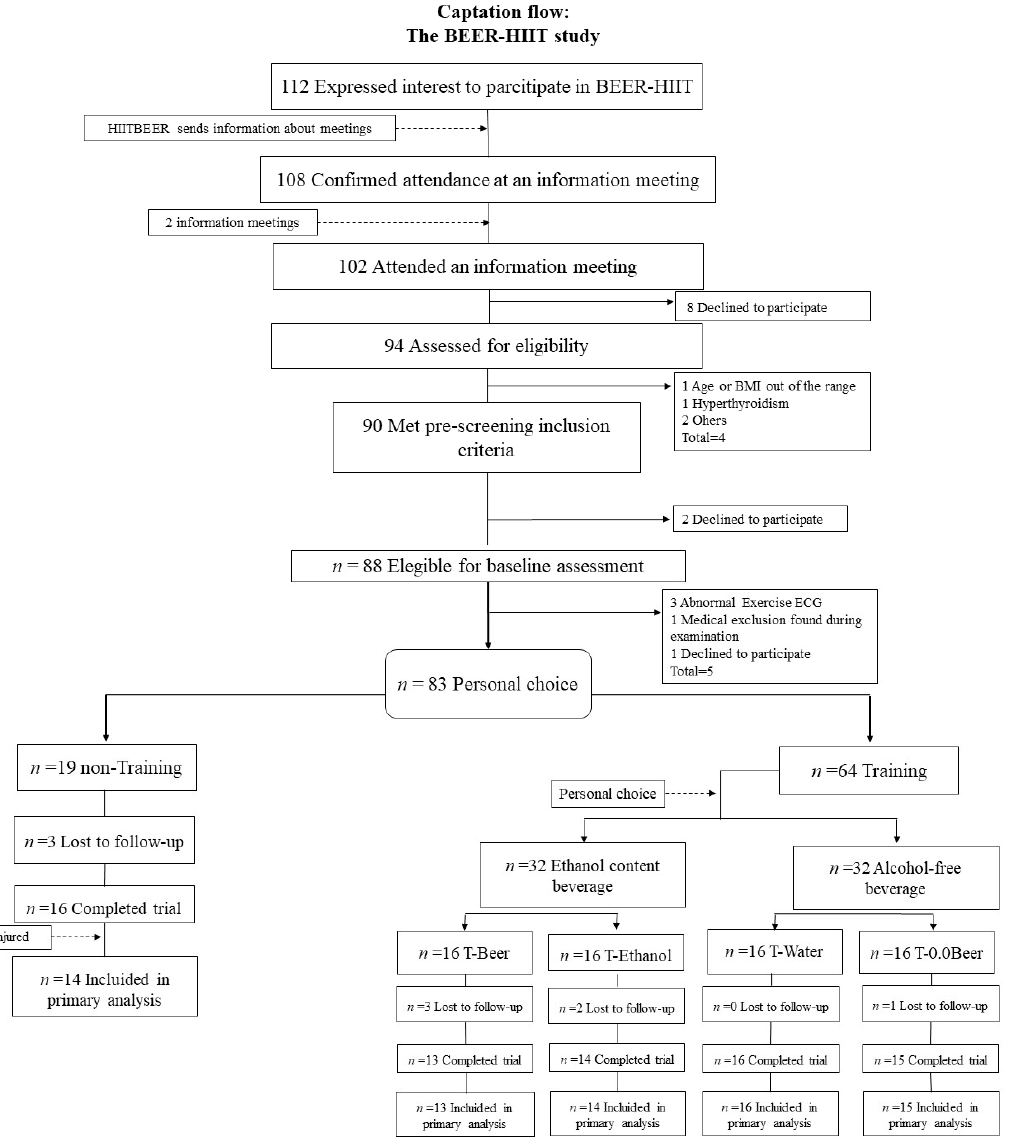
Figure 1. Flow-chart diagram. Abbreviations: BMI, body mass index; ECG, electrocardiogram; N-T, non-training group; T-Beer, group that performed HIIT and consumed alcohol beer; T-0.0Beer, group that performed HIIT and consumed non-alcoholic beer; T-Water, group that performed HIIT and consumed sparkling water; T-Ethanol, group that performed HIIT and consumed sparkling water with alcohol added.